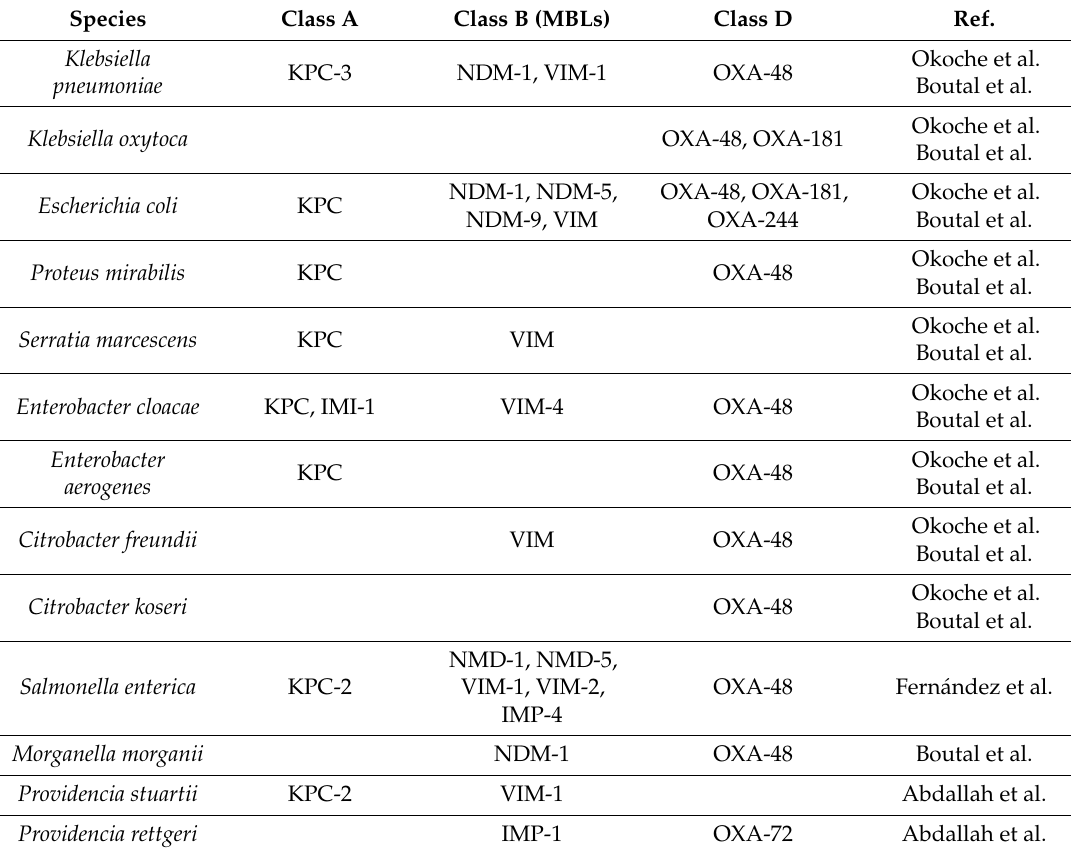
Table 1. Carbapenemases detected in di ff erent species belonging to the Enterobacteriaceae